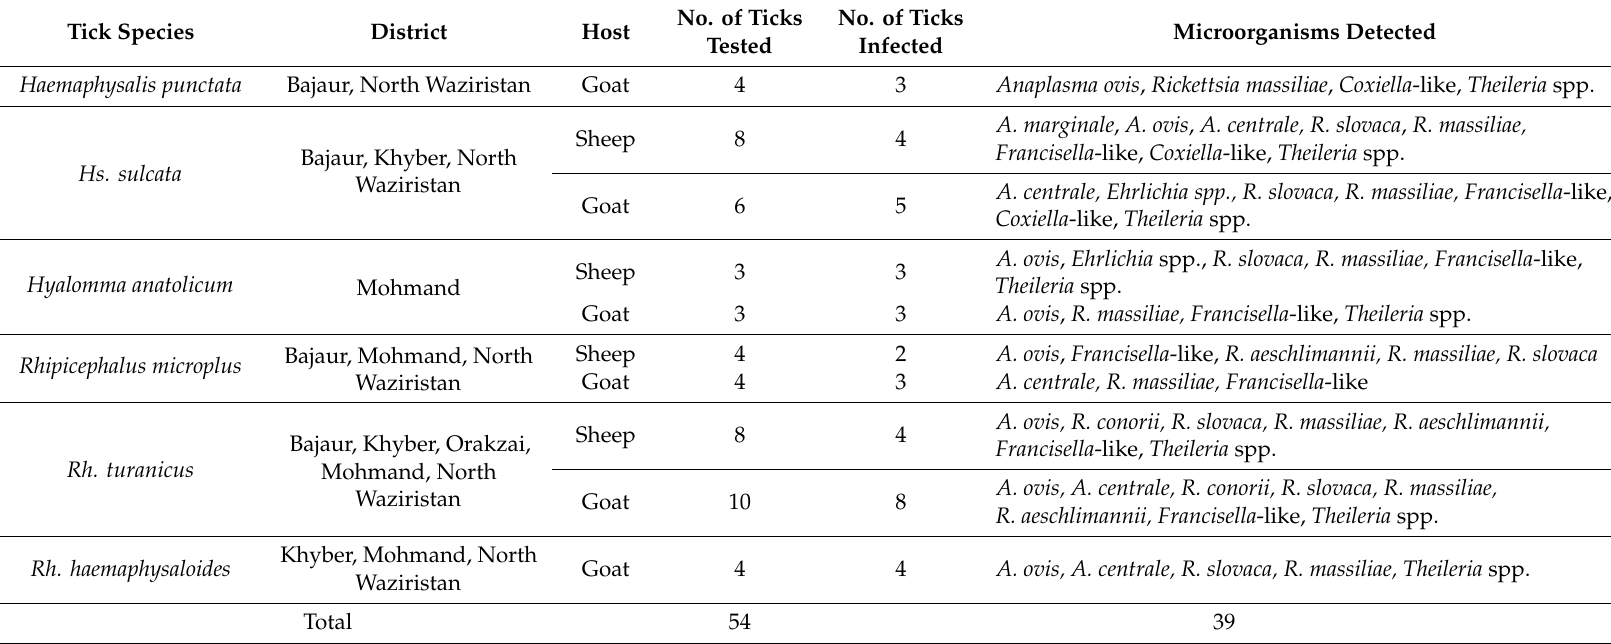
Table 2. Occurrence of various microorganisms in six tick species of small ruminants from the FATA of Pakistan. Tick